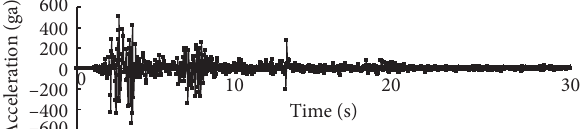
Figure 6: Curve of time-acceleration of south-north